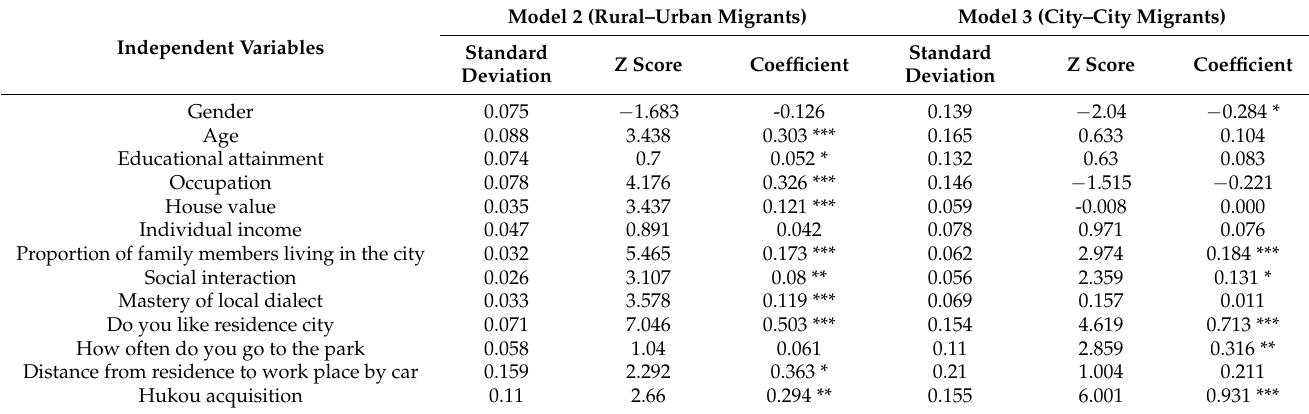
Table 8. Probit regression analysis of settlement intentions in city–city and rural–urban migrants.